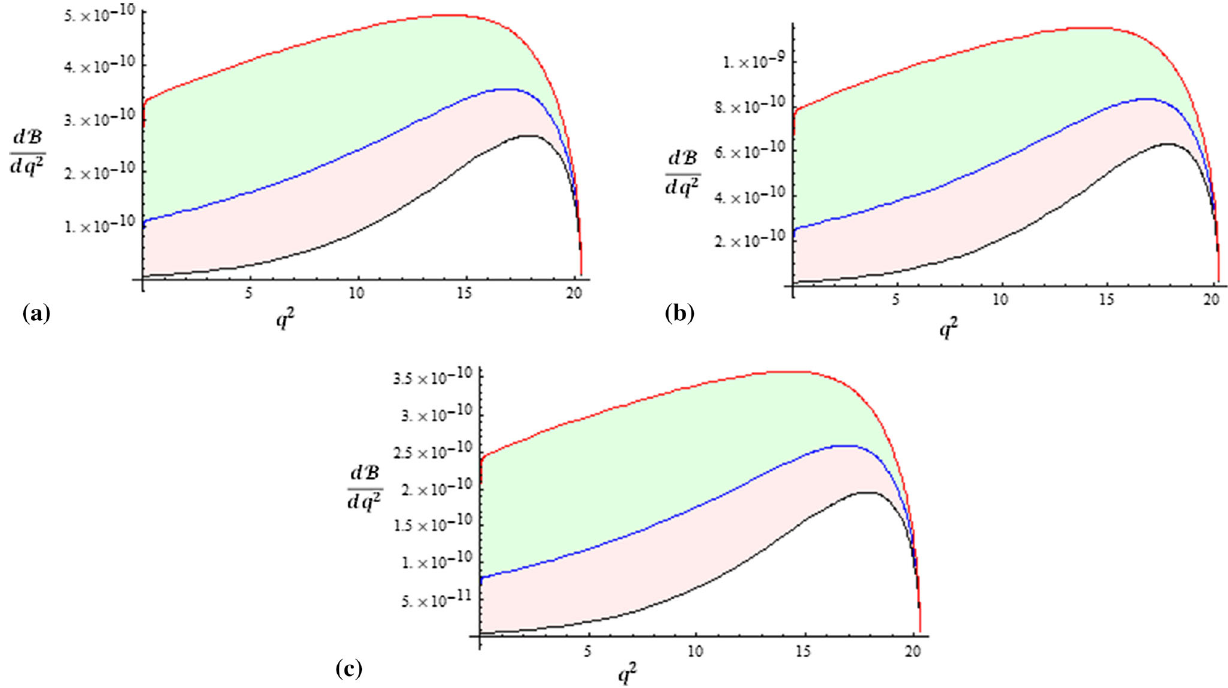
Fig. 2 Variation of differential branching ratio for (cid:2) b → (cid:2)μ + e − within allowed kinematic region of q 2 using the bound of NP couplings for a scenario 1, b scenario 2 and c scenario